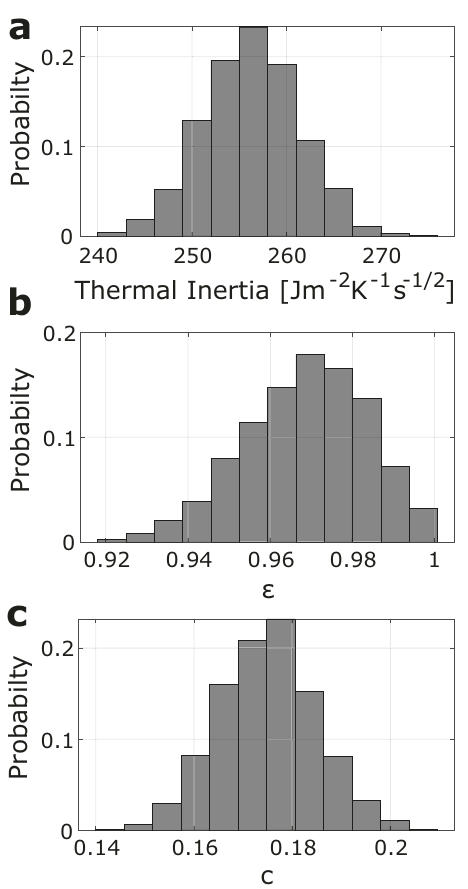
Fig. 3 Estimated parameter distributions. Histograms over the posterior parameter distributions for ( a ) thermal inertia, ( b ) broadband emissivity ε ( c ) and crater density of the roughness model c , with y axis representing the probability of a parameter value within the interval given by the histogram bars. Parameter combinations with emissivity >1 are discarded. The histograms are formed from the results of the data assimilation and represent the uncertainty of the parameter estimation according to the observation uncertainty. Source data are provided as a Source Data fi le.